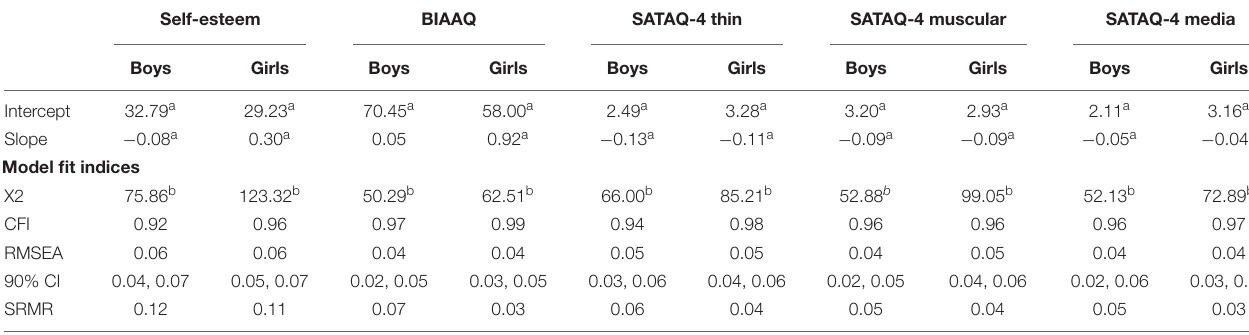
TABLE 3 | Intercept, slope, and model fit indices for the mediation models for each mediator. Self-esteem BIAAQ SATAQ-4 thin SATAQ-4